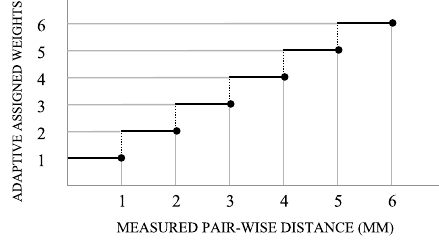
Figure 15. Assigning adaptive weight with respect to the range of the measured